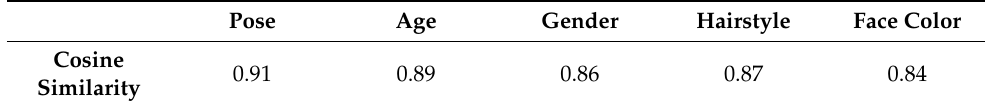
Table 1. Semantic attribute editing direction cosine